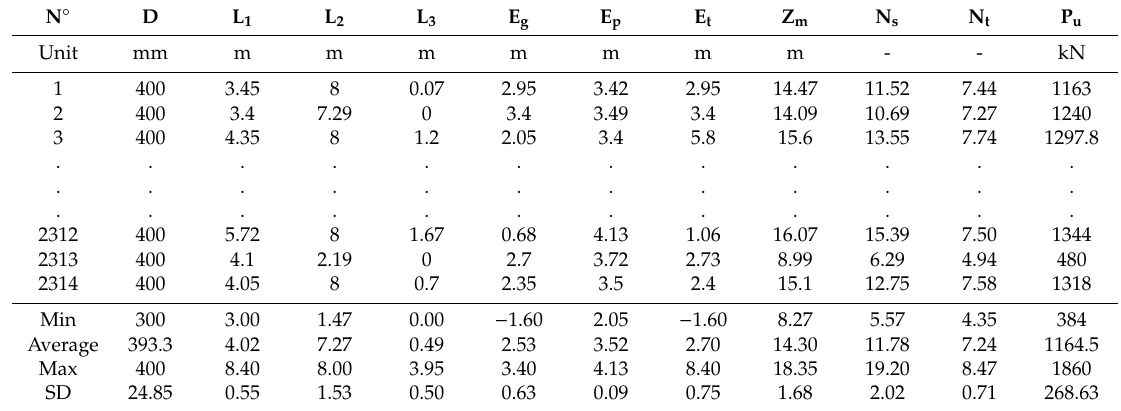
Table 1. Inputs and output of the present study